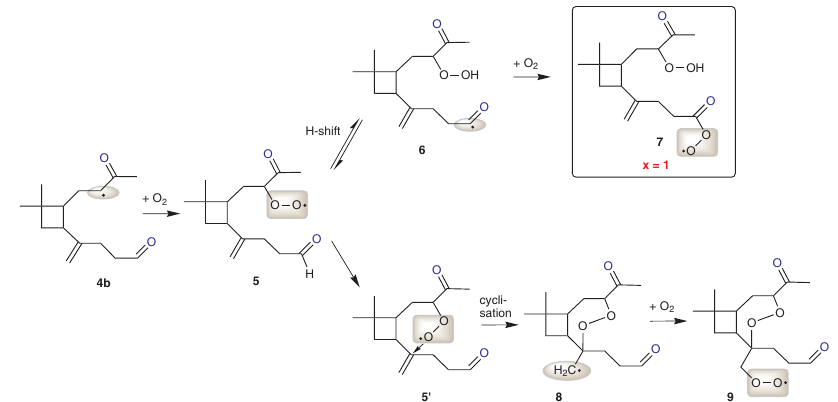
Figure 7. Further reaction steps of the alkyl radical 4b. Oxygen atoms arising from the attacking ozone are highlighted in blue, alkyl radical functional groups with a shaded oval and RO 2 radical functional groups with a shaded rectangle. Detected species are surrounded by a solid rectangle. The stated position, where the internal H-transfer takes place 5 → 6, represents an example